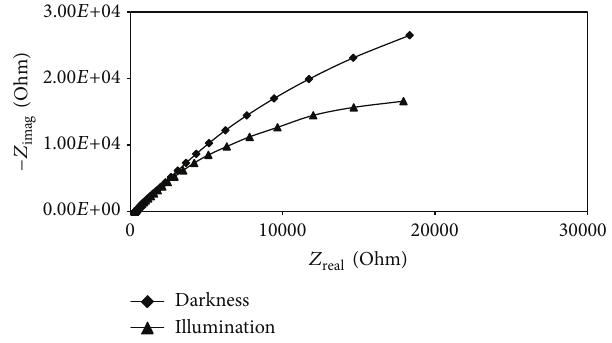
Figure 6: Nyquist curves of ITO/EB-MWCNT/ZnO-riboflavin/ ITO structure in darkness and illumination.